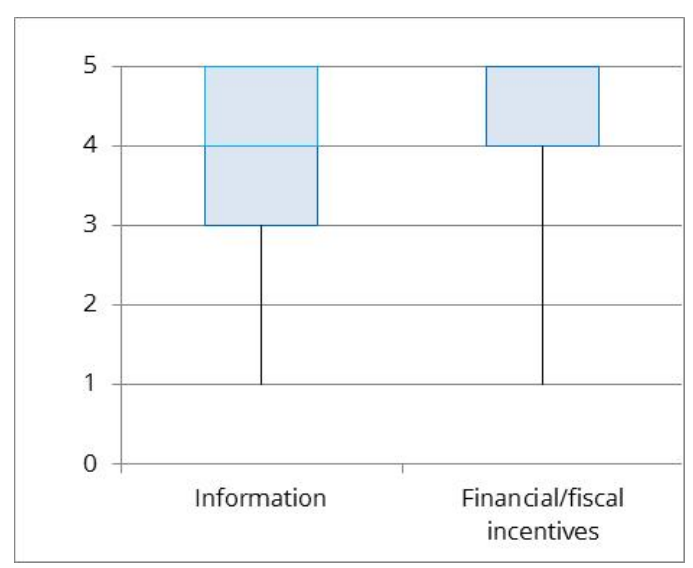
Figure 9. Causes for reduced local interest in WrGIs/SuDSs: ( 1 ) traditional systems are reliable and recognised; ( 2 ) the long-term maintenance costs of WrGIs/SuDSs are considered problematic; ( 3 ) the construction costs of WrGIs/SuDSs are considered higher than those of the grey infrastructures; ( 4 ) little general interest in the area for WrGIs/SuDSs; ( 5 ) there is interest in WrGIs/SuDSs in the area.